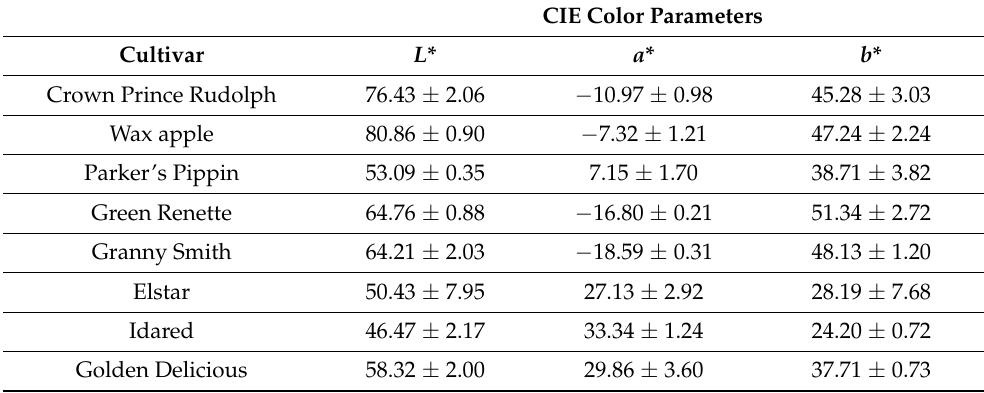
Table 3. CIE color